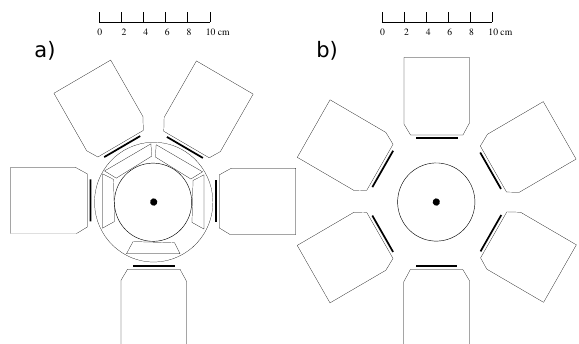
Figure 1. Comparison between the old and new setups. The pre- vious setup (a) used 5 telescopes, each with a MWPC to gather the position of the particles and a thin scintillator in front of the main one to di ff erentiate electrons and positrons from gammas. The new setup (b) consisted of 6 telescopes, and the MWPCs was replaced by DSSDs, which can be used for the particle identifi- cation, removing the need for the thin